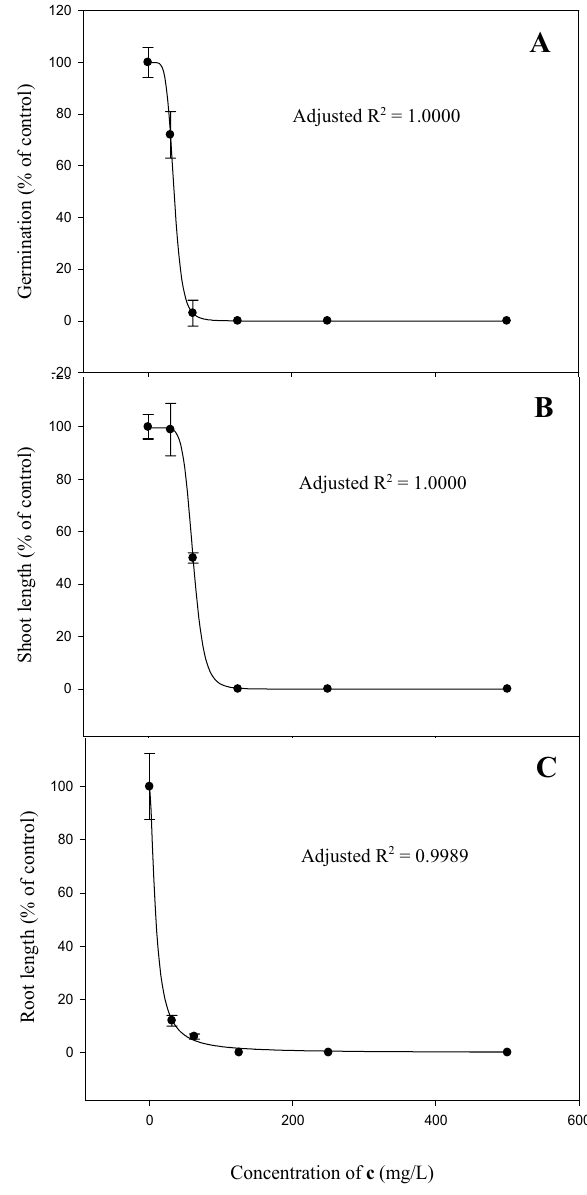
Figure 3. Inhibitory effect of 5-(3-Fluoro-phenyl)-7-methyl-5H-thiazolo[3,2-a]pyrimidine-6-carboxylic acid ethyl ester ( c ) on germination ( A ), shoot length ( B ) and root length ( C ) of Eleusine indica after 7 days of treatment. The standard deviation of the mean is symbolized by the vertical bar.